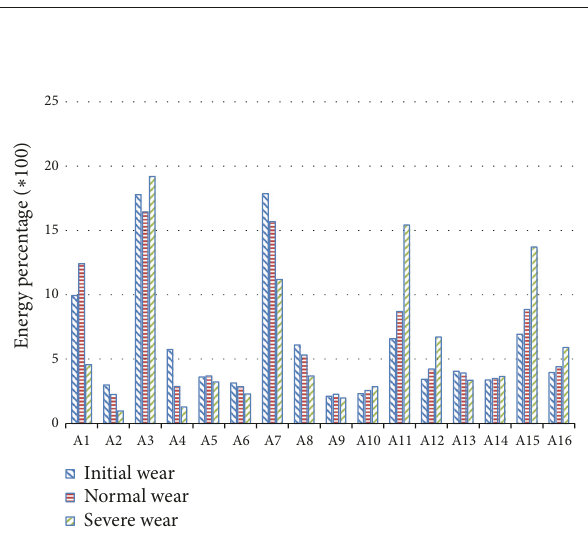
Figure 15: Energy proportion of the vibration signal in each frequency band after wavelet packet